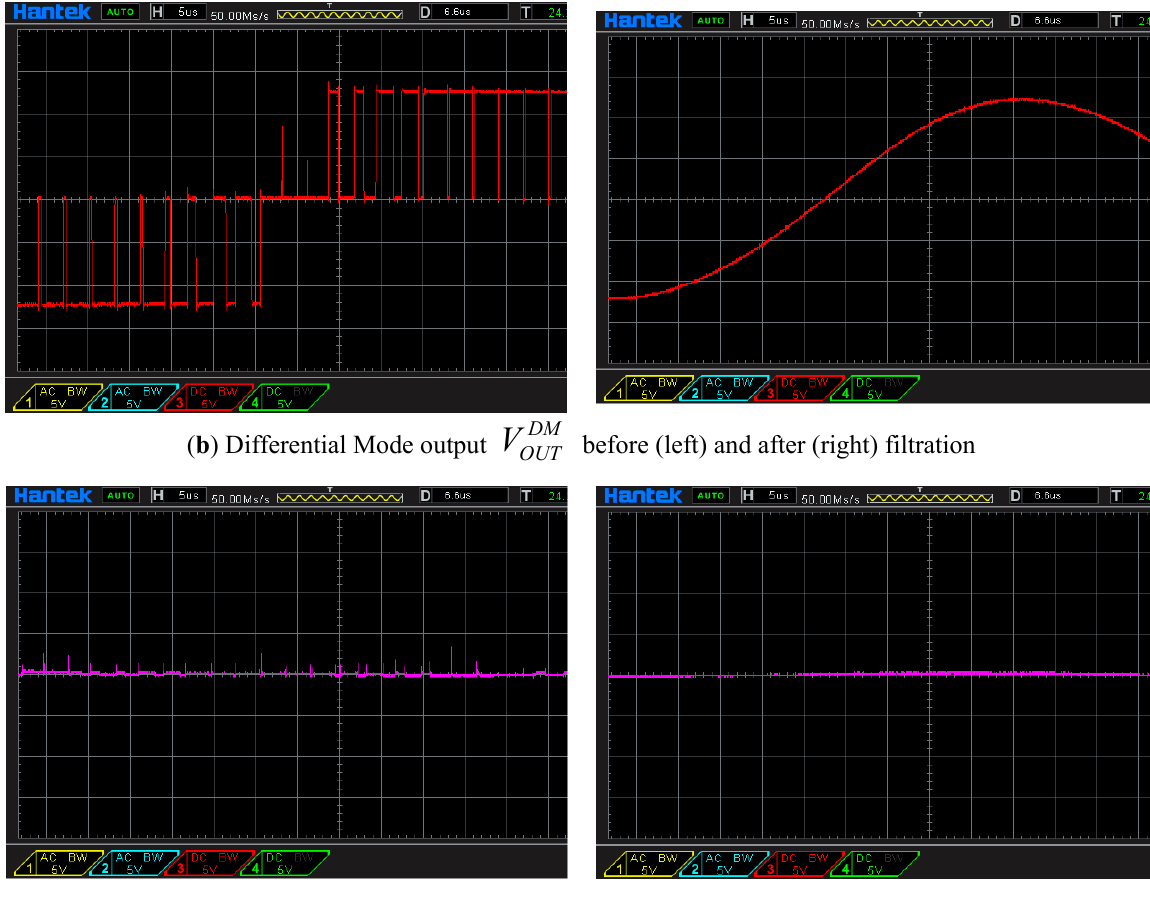
Figure 9. Ocillograms measured at the following outputs of the Class ‐ BD amplifier in Figure 5: ( a ) Left ‐ half and right ‐ half H ‐ bridge outputs, ( b ) DM output, ( c ) CM output (in the left column before, in the right column after filtration); F c 2 = 164 kHz, f m = 10 kHz; vertically: 1 div/5 V; horizontally: 1 div/5 µ s; V DD = 24